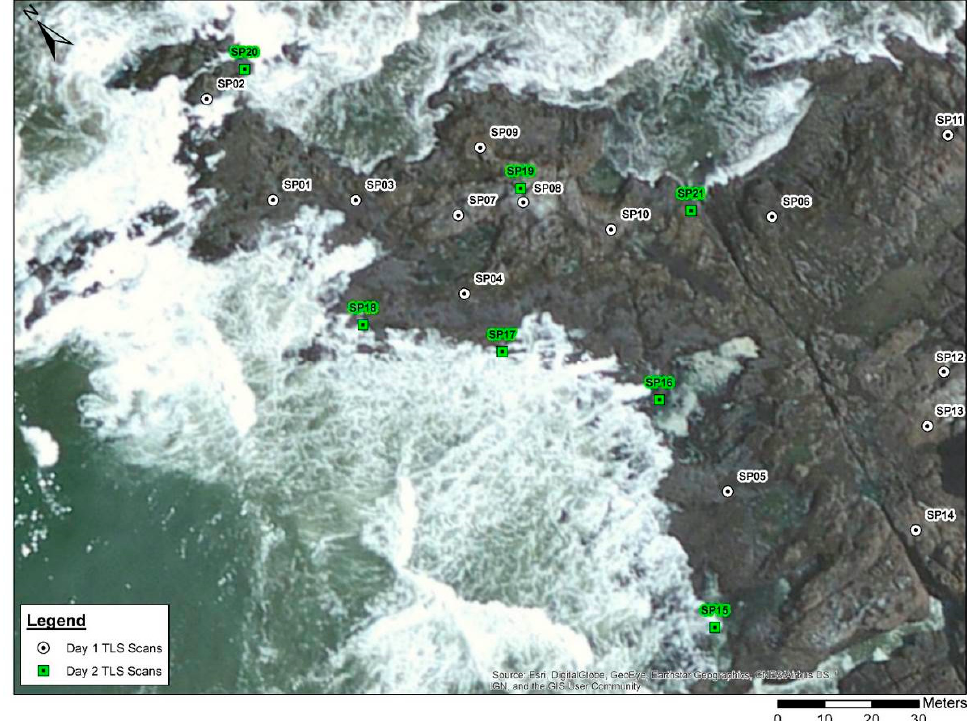
Figure 11. Overview map of Rabbit Rock site with locations of TLS scan positions.